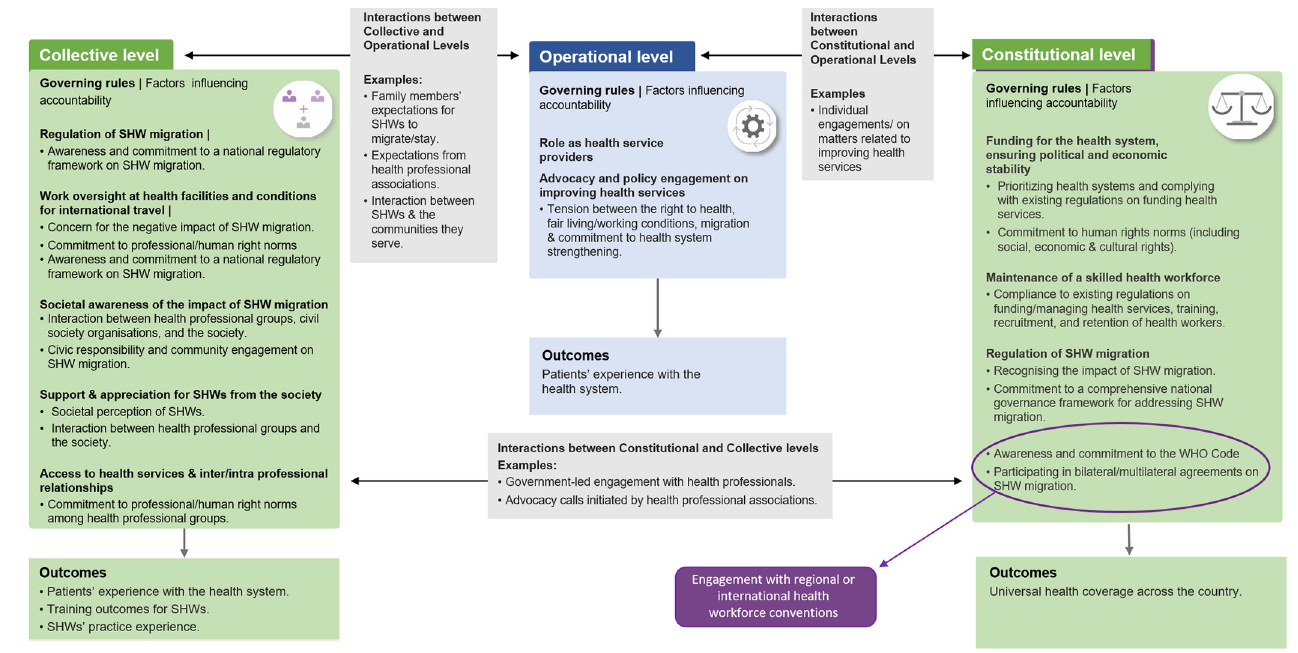
Fig 2. Governance framework for skilled health worker migration in